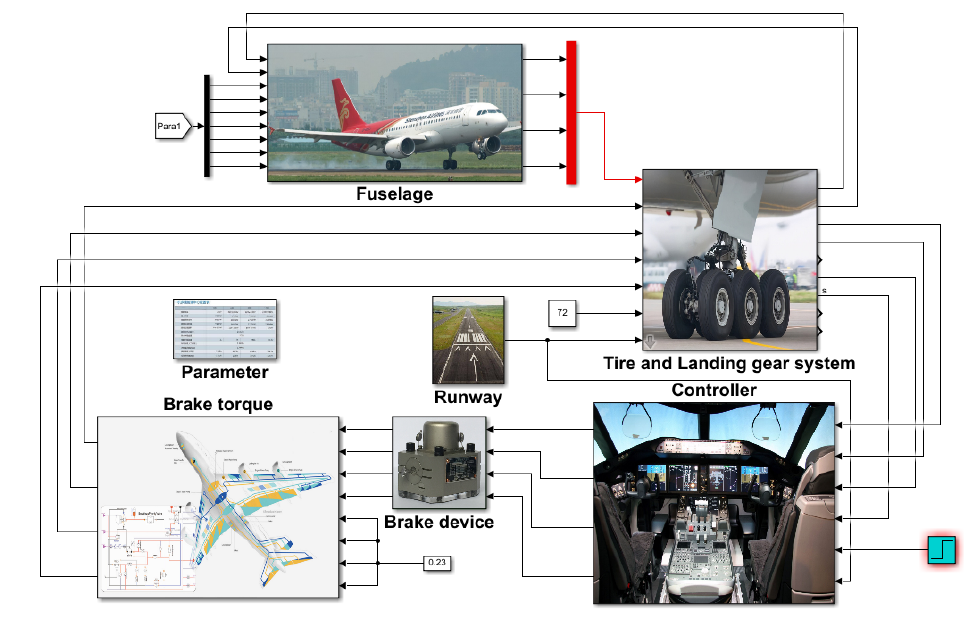
Figure 11. The Simulink model established in this research.